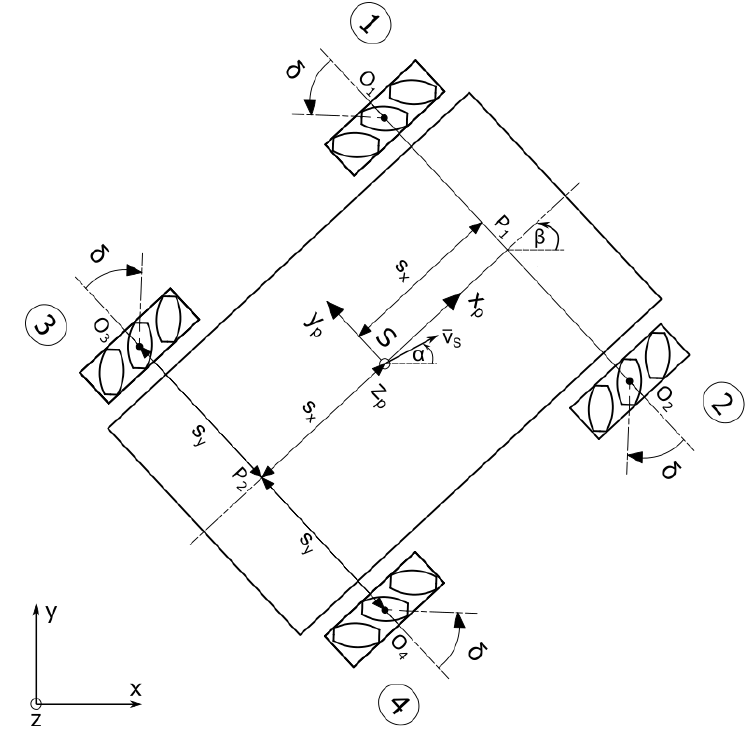
Figure 1. Diagram of the wheeled mobile robot.